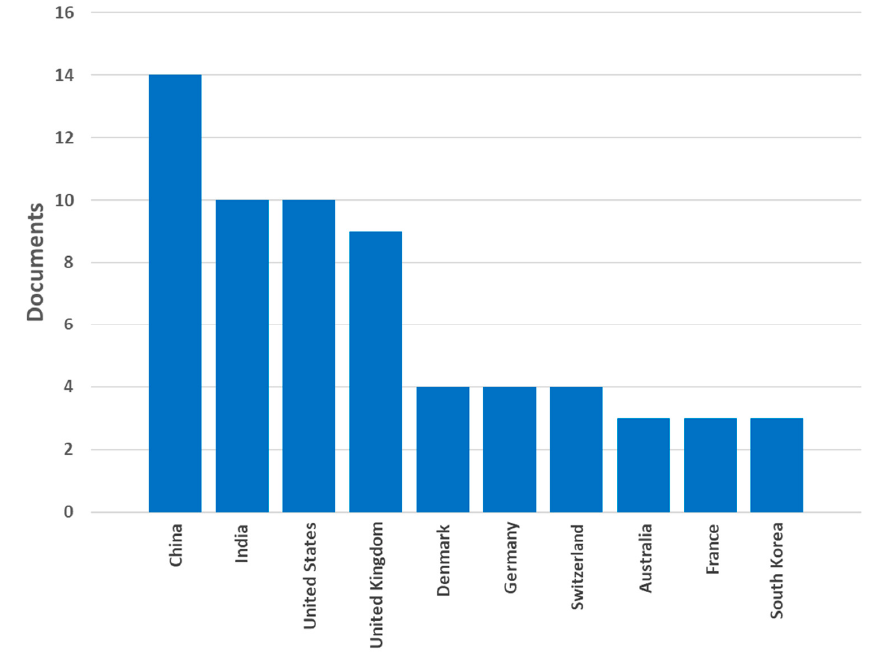
Figure 6. Analyzed documents by country/territory .